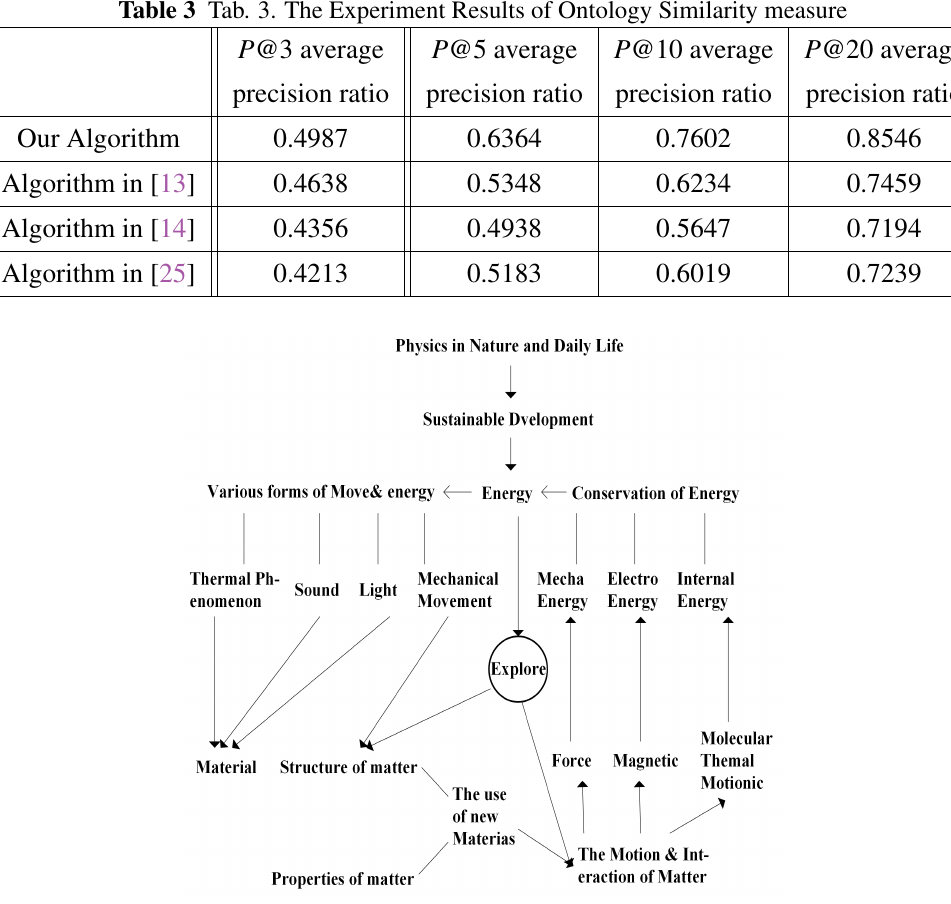
Fig. 5 “Physics Education” Ontology O 5